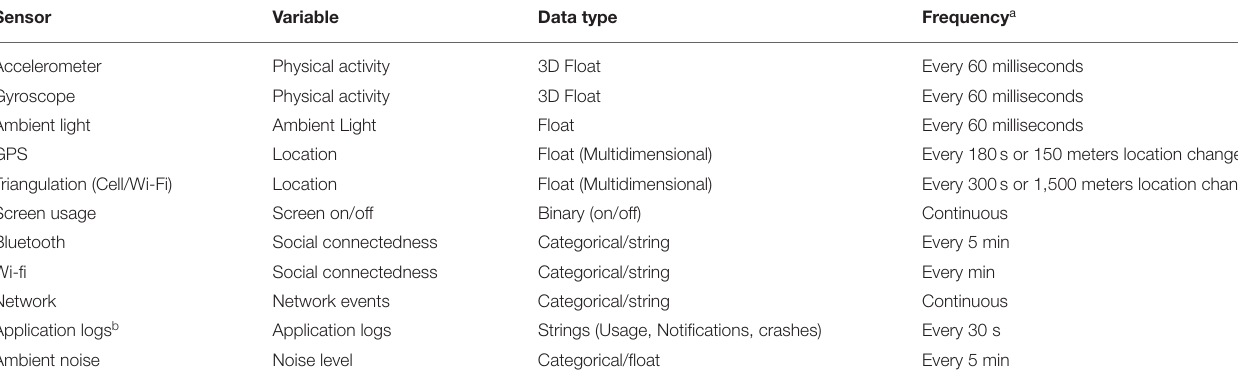
TABLE 3 | Data sources, data types and collection frequency of the SIMON-SENSE application.